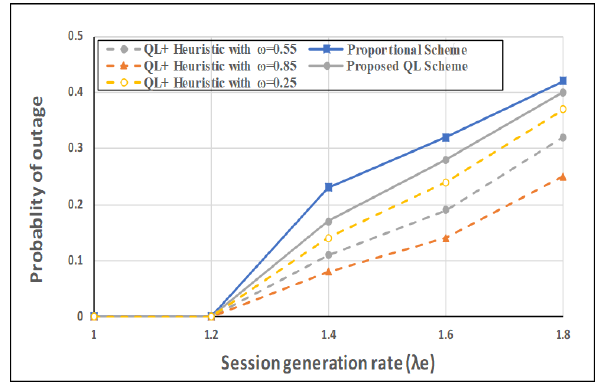
Figure 6. Outage probability as a function of the eMBB session generation rate λe